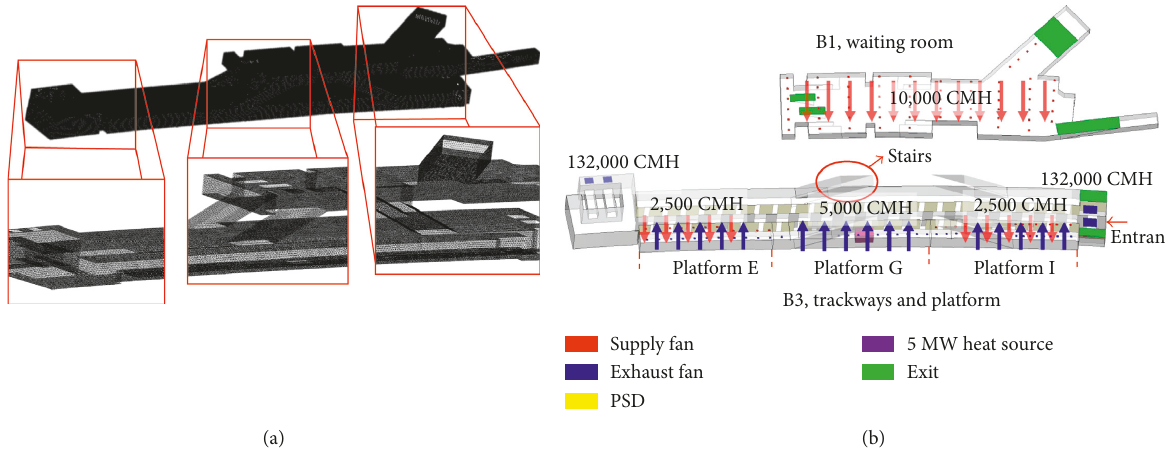
Figure 2: Mesh model, boundary conditions, and ventilation system. (a) Mesh model. (b) Boundary conditions and ventilation